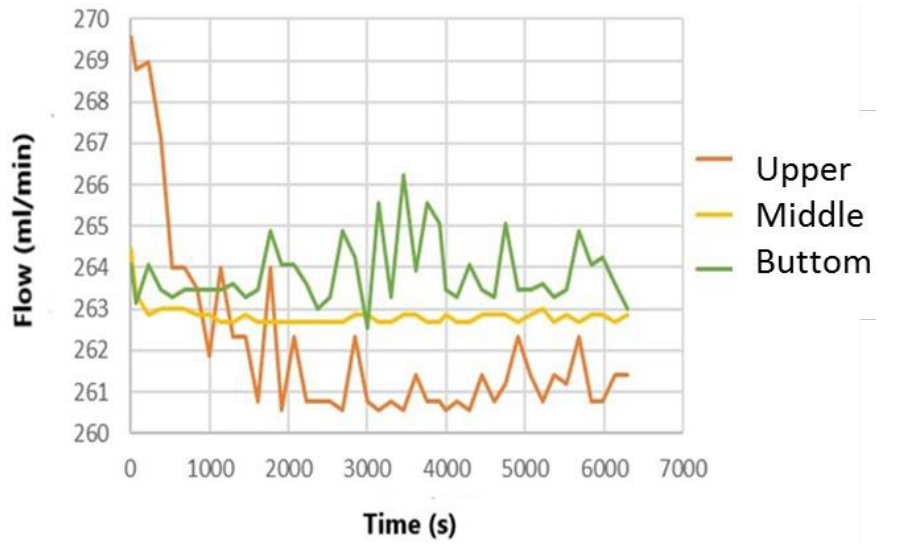
Figure 17. Runner flow distribution curve.